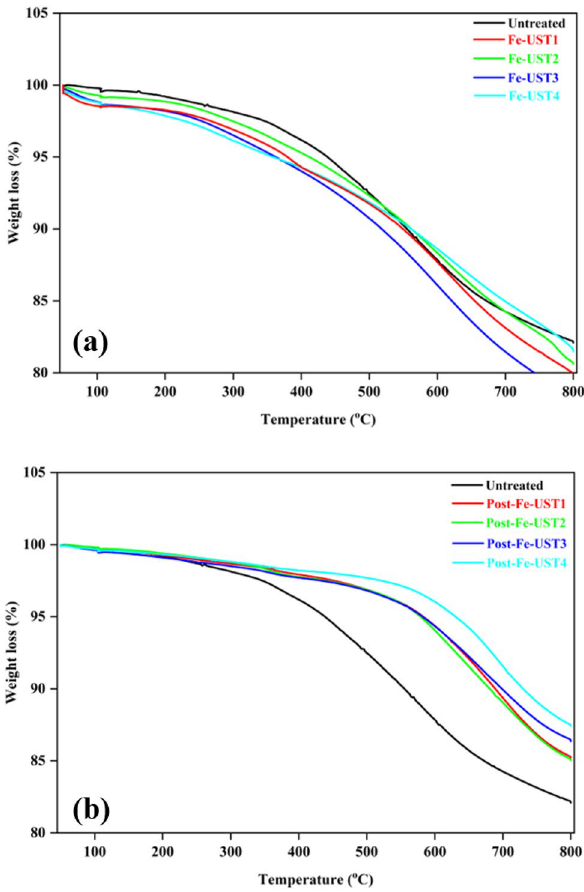
Fig. 6 Thermogravimetric analysis of Fe-impregnated biochars pre- pared using (a) Pre-pyrolysis method (b) Post-pyrolysis